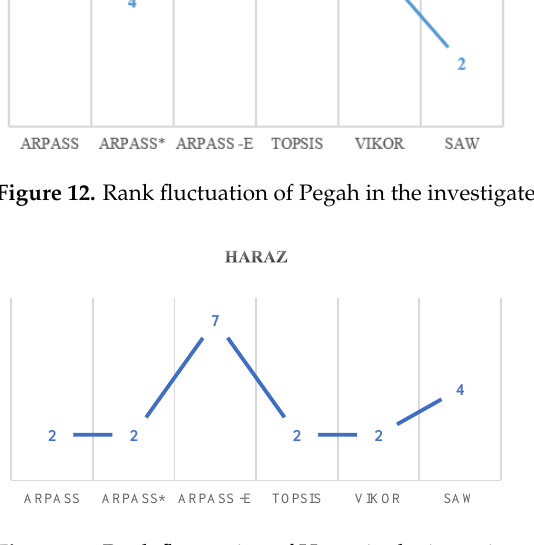
Figure 13. Rank fluctuation of Haraz in the investigated MCDM methods.